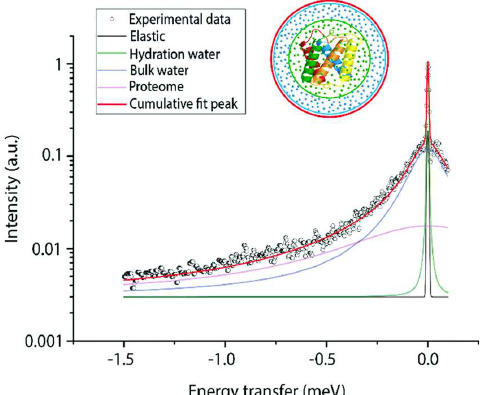
Fig. 16 . Normalized QENS spectra and fit for T. barophilus at 298 K, 40 MPa and Q = 0.96 Å -1 on a semi- logarithmic scale. Scheme in the red circle represents the different populations studied, the ribbons represent a protein, and the dots represent water molecules (green for hydration water and blue for bulk water). Reprinted with permission from [105]. Copyright 2019 The Royal Society of